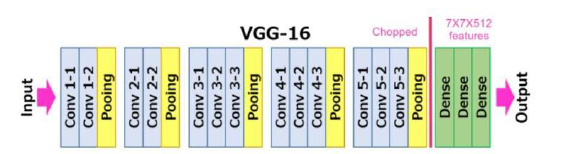
Figure 6 . VGG16 network architecture with transfer